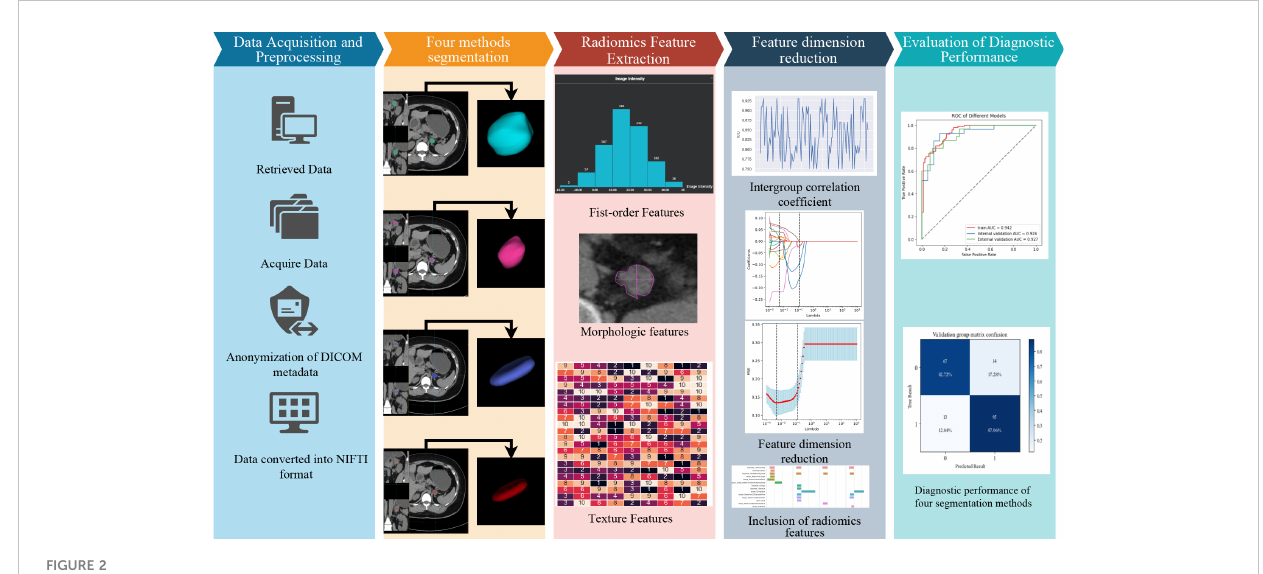
FIGURE 2 Radiomics analysis fl